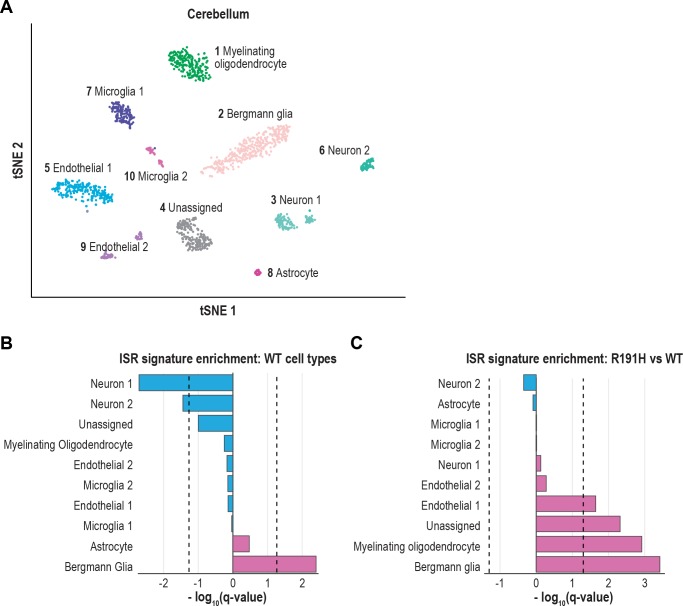
The ISR is strongly activated in Bergmann glia of VWM cerebellum.(A) tSNE plot showing the 10 cell type clusters identified from scRNA-seq analysis of WT and R191H cerebellum. (B) Q-values from GSEA based on the differential expression analysis of each WT cluster versus all other WT clusters, using the ISR gene expression signature derived from CLIC. (C) Q-values from the differential expression analysis of R191H vs WT cells for each cluster, using the same ISR signature as in (B). In (B) and (C), dotted lines indicate Q-value thresholds of 0.05.